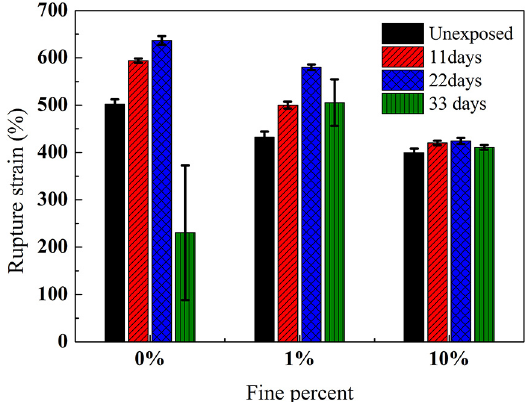
Figure 4. Rupture strain with the UV time exposure of UHMWPE and their compounds with 1 and 10% of iron ore fine. Surigo usar nas abcissas “Filler content